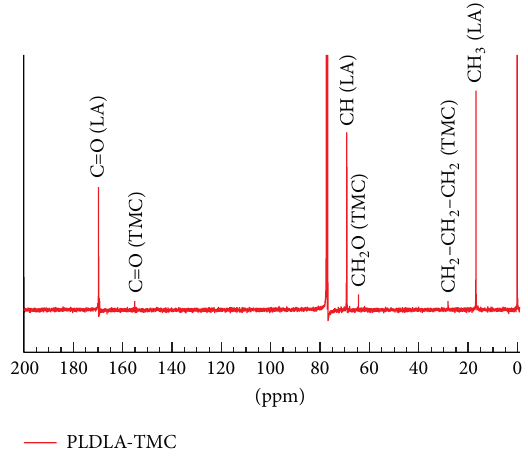
Figure 2: 13 C NMR spectrum of PLDLA-TMC.